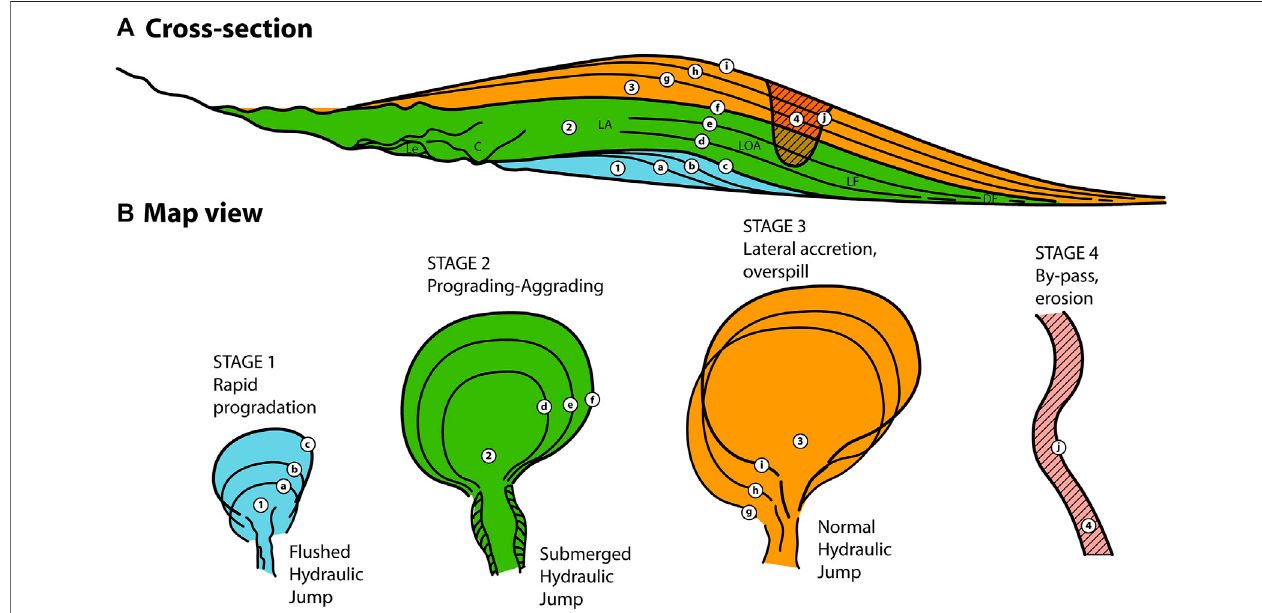
FIGURE 14 | Depositional model for intraslope lobes based on the Motta San Giovanni Formation (Miocene, Calabria). Stage 1: increasing sediment supply associated with rapid progradation of the lobe in response to fl ushed hydraulic jump in the Channel-Lobe transition zone. Stage 2: high sediment supply in balance with depositionalprocessesandaccommodationspaceresultinginaprograding-aggradingtrend.Channel-Levee(L-Le)faciesassociationiswellpreserveddirectlyupdipto the Lobe axis (LA) facies association. Stage 3: high sediment supply is not at equilibrium with accommodation space and depositional system size resulting in overspill processes and lateral accretion. Stage 4: unstable and unbalance system recorded by bypass and erosion progresses.